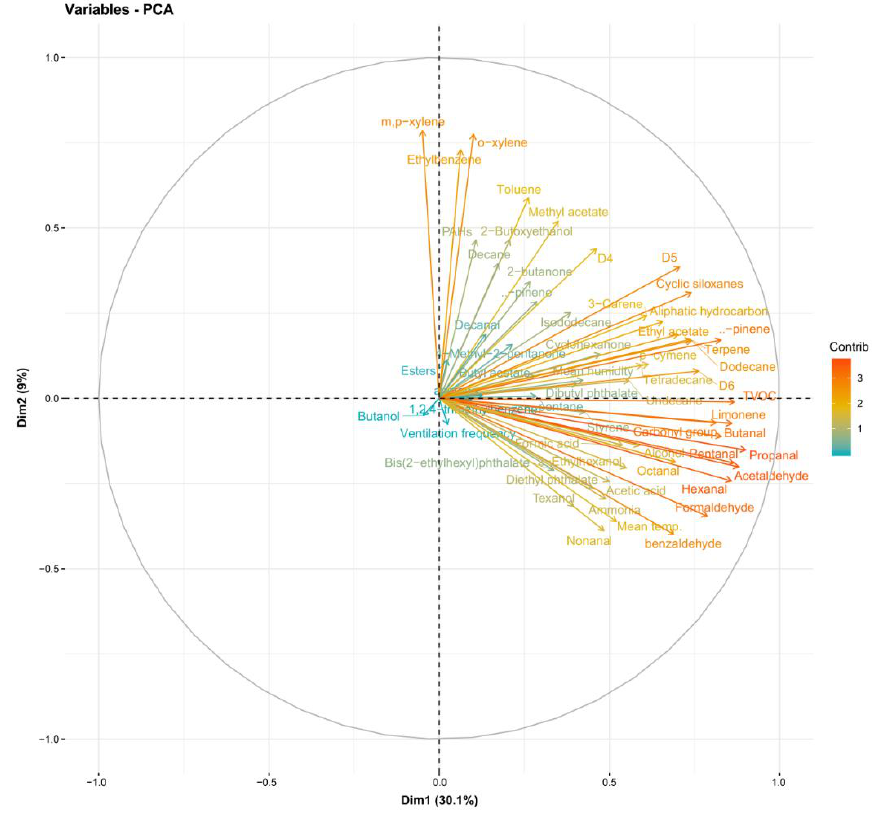
Figure 2. Loading of principal components.